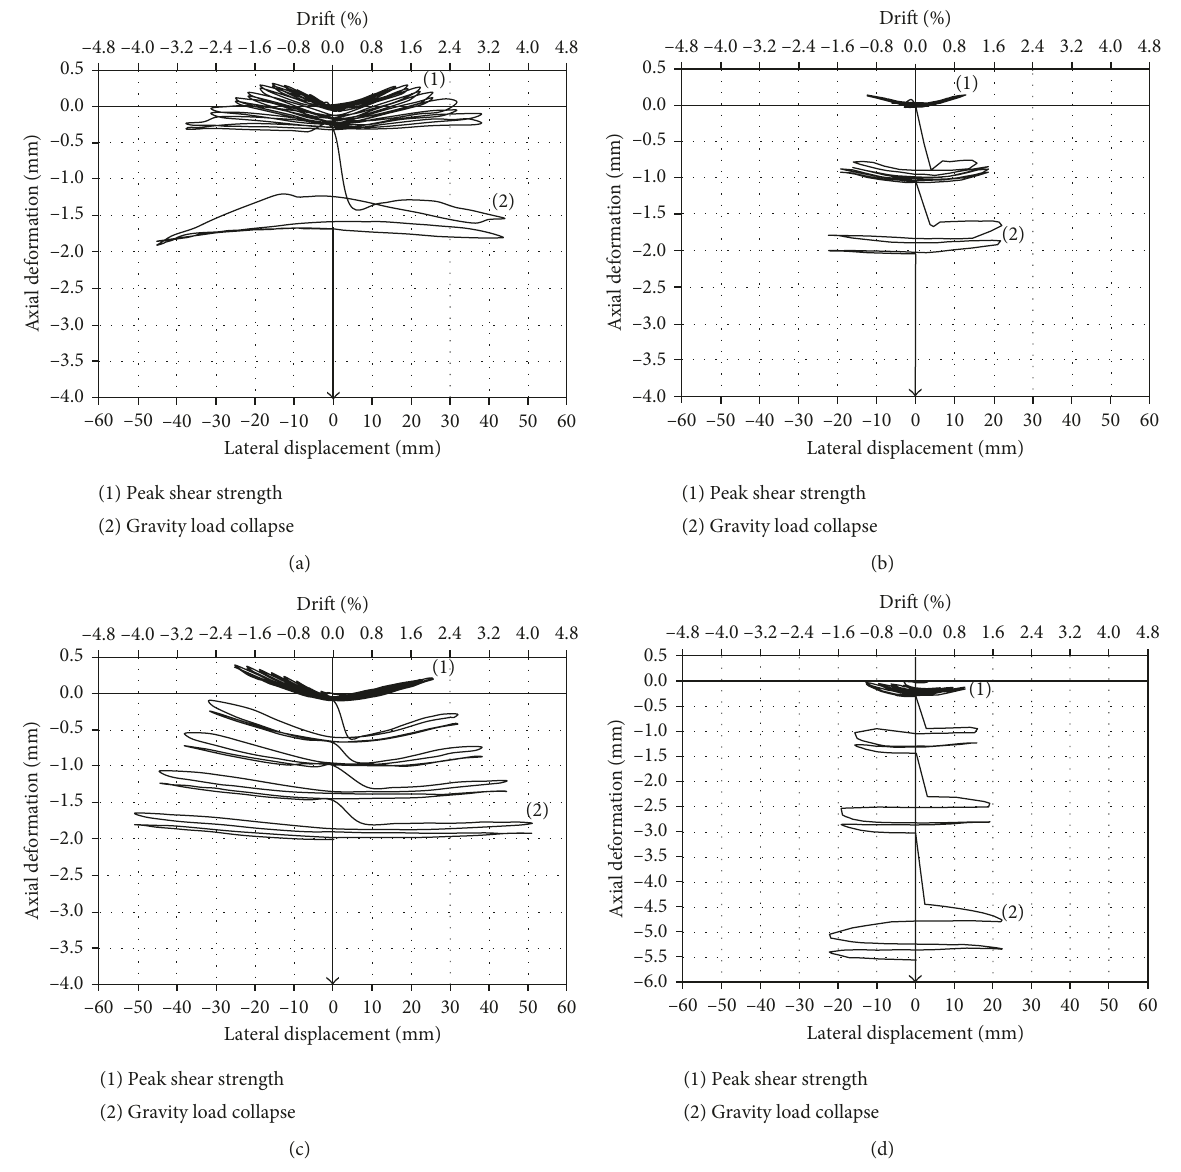
Figure 9: Axial displacement-drift ratio response. (a) 12L-0.2; (b) 12L-0.6; (c) 9L-0.2; (d)